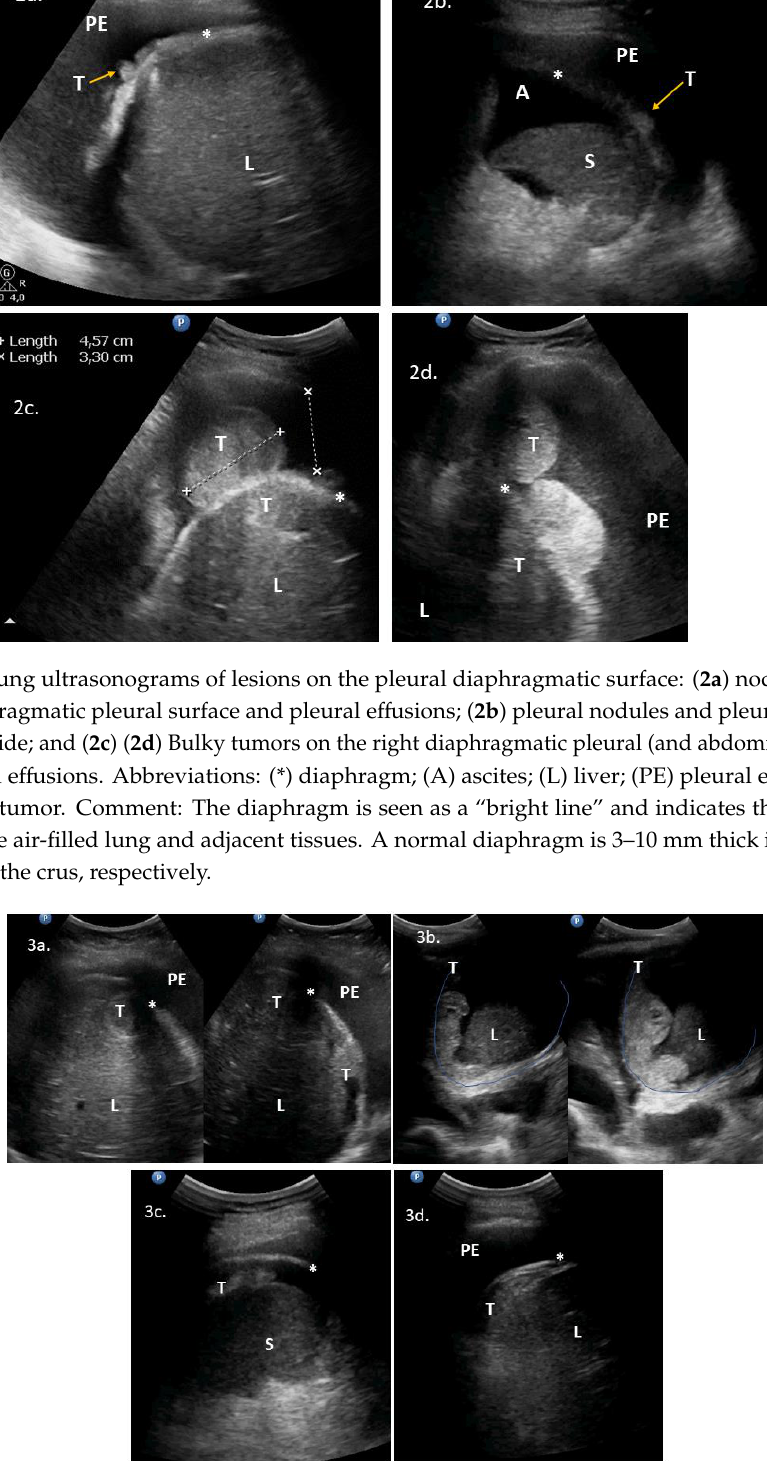
Figure 3. Intercostal upper abdomen ultrasonograms of lesions on the abdominal diaphragmatic surface: ( 3a ) bulky tumors between the liver and diaphragm; ( 3b ) solid-cystic tumors between the liver and diaphragm; ( 3c ) tumor on the spleen surface; and ( 3d ) plaque lesion on the right posterior abdominal surface of the diaphragm and pleural e ff usions. Abbreviations: (*) diaphragm; (L) liver; (PE) pleural e ff usions; (S) spleen; (T)